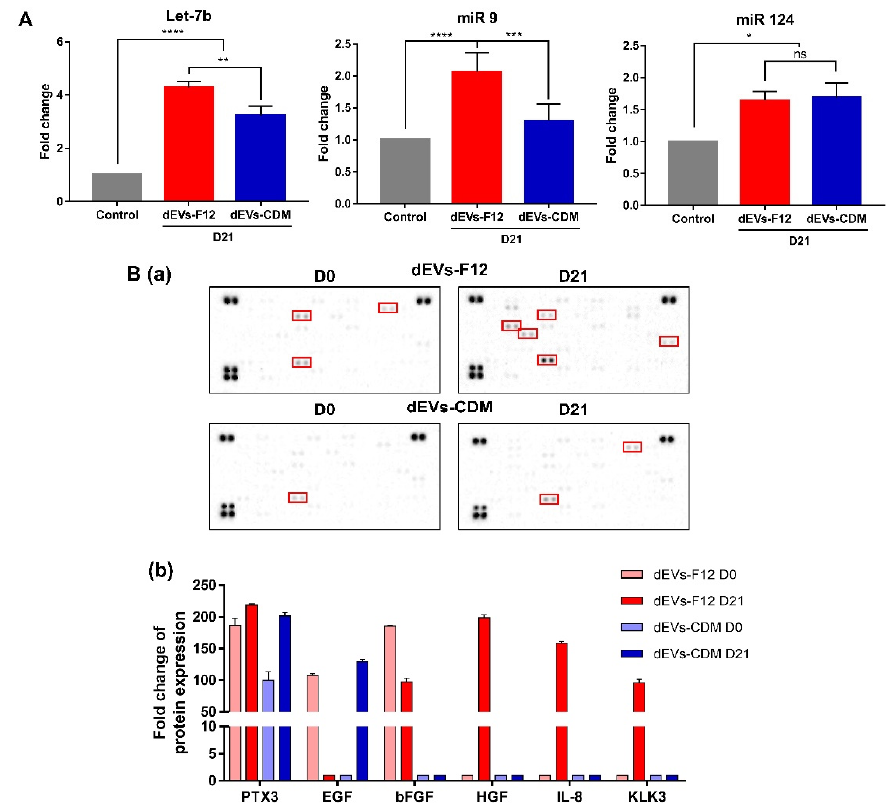
Figure 5. miRNA expressions for Let-7b, miR 9, and miR 124. ( A ) Quantification of the miRNA expressions related to neurogenesis of dEVs using RT-qPCR. ( B ) Cytokine expressions in dEVs. Representative images of cytokine array membranes ( a ) and quantification as a fold change ( b ). **** p < 0.0001, *** p < 0.001, ** p < 0.01, * p < 0.05, and ns = no significant. One-way ANOVA was followed by Tukey’s test. Error bars represent standard deviation (SD).